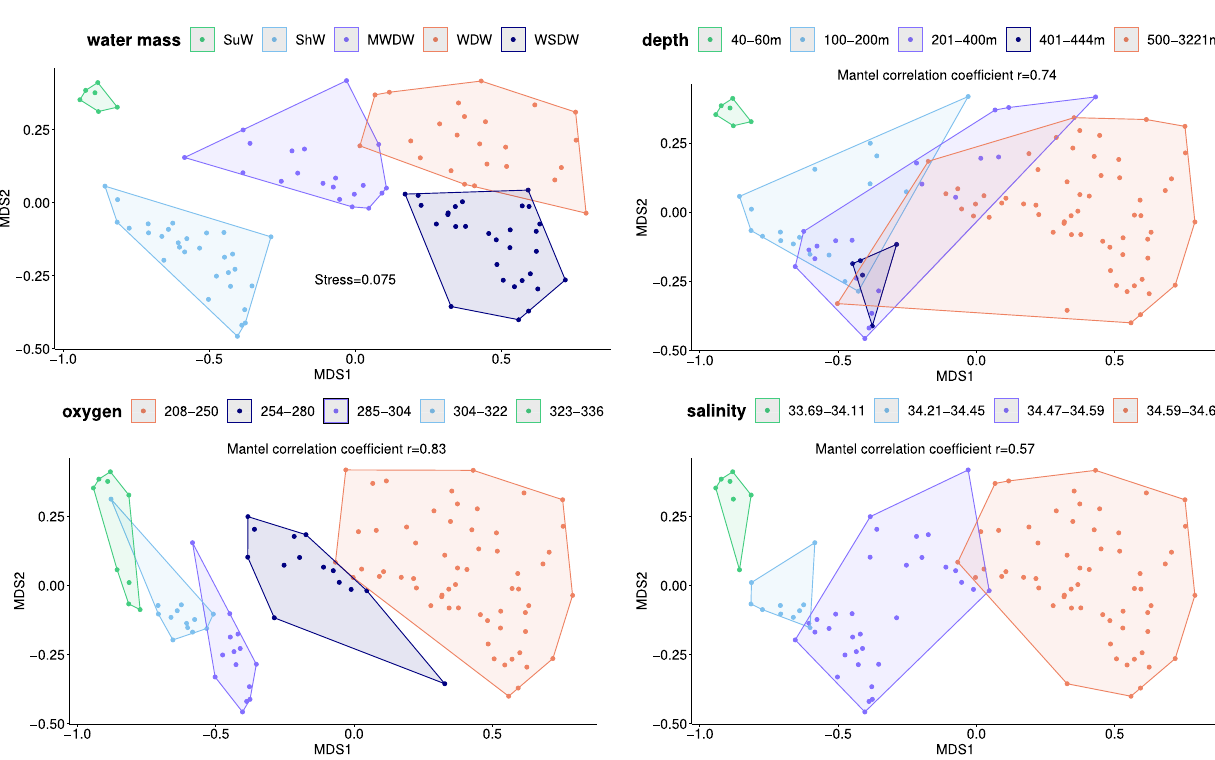
Fig. 2 Two-dimensional NMDS plots illustrating pairwise Bray-Curtis distances between pico-nano eukaryotic communities in the Western Weddell Sea. All NMDS plots are identical (with a stress value = 0.075 shown in an upper left panel), but the samples are clustered in different ways as described below. The water masses are mapped on the NMDS plot in the upper left corner along with three most important abiotic variables (see the other three plots): depth, oxygen concentration, and salinity. Boundary points on gradients of those abiotic variables (where pico-nano eukaryotic community composition is signi fi cantly different across the boundary) were identi fi ed using a split moving-window analysis of ecological differentiation based on a Z-score cutoff of 1, and samples were clustered according to these boundary points. The clusters are colored and marked with polygons. The intervals of the abiotic variable corresponding to the clusters are shown in the legends on top of each plot. Mantel correlation coef fi cients (calculated for the matrix of Bray-Curtis distances between the pico-nano eukaryotic communities and for a matrix of Bray-Curtis distances between the samples based on an abiotic variable) are shown for each continuous variable. For similar mapping of the other environmental variables measured in this study see Suppl. Fig. 1. The source data underlying this fi gure see in Suppl. Data 1 and Suppl. Data